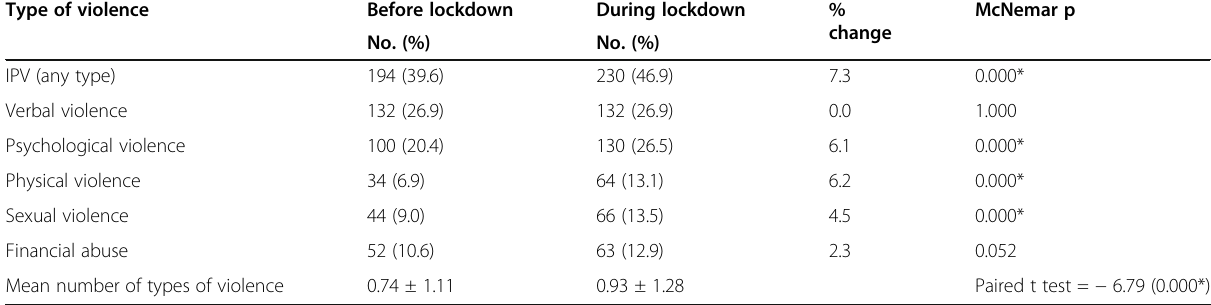
Table 1 Distribution of adult Arab women according to their exposure to IPV before and during COVID-19 lockdown Type of violence